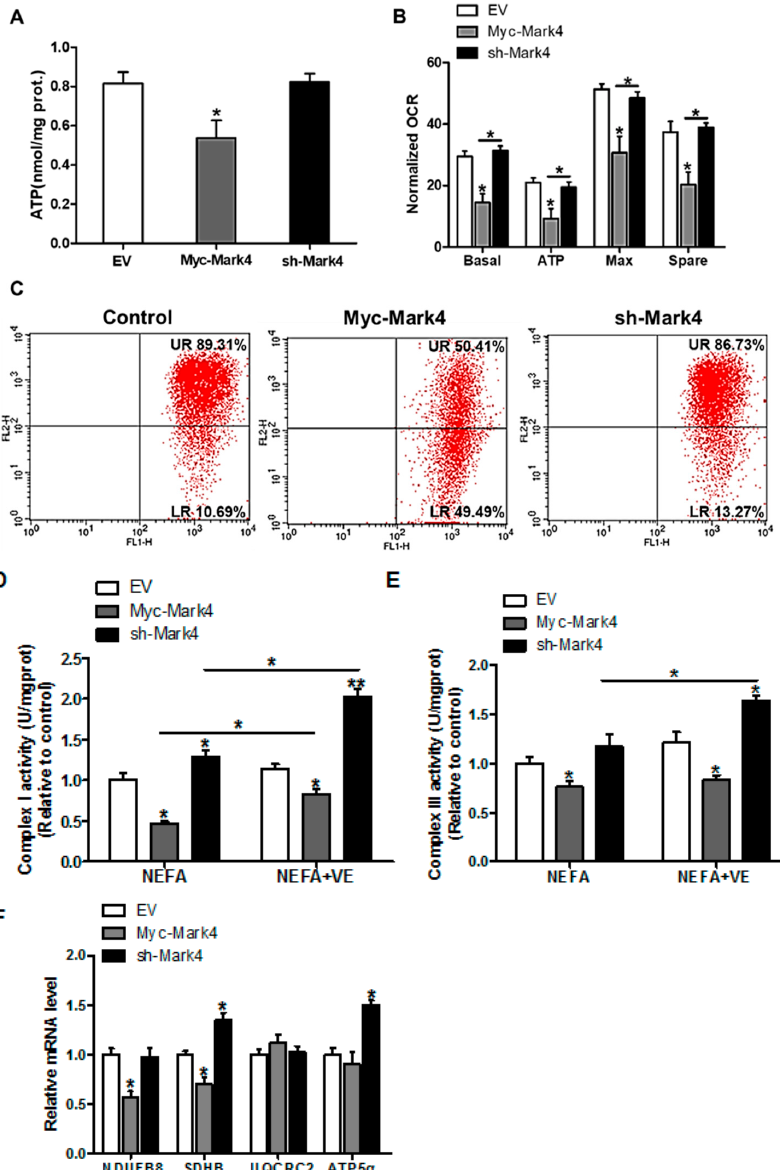
Figure 2. MARK4 blocks mitochondrial oxidative respiration in pig primary trophoblast cells chal- lenged with 400 μ M NEFA. ( A ) Mitochondrial ATP production after transfection with Myc-MARK4, sh-MARK4 for 48 h in cytotrophoblasts. Before assessment of ATP generation, cells were incubated with 400 μ M NEFA for 24 h ( n = 3); ( B ) Mitochondrial respiratory parameters were measured in pig cytotrophoblasts after transfection with Myc-MARK4, sh-MARK4 for 48 h. Cells were then treated with 400 μ M NEFA for 24 h ( n = 3). Oxygen consumption rate (OCR) measurements were normal- ized to total protein level of whole cell lysates extract (pmol O 2 / μ g protein); ( C ) Impaired mitochon- drial function was estimated by JC-1 fluorescent staining using flow cytometry in cytotrophoblasts ( n = 3). The upper right (UR) quadrant depicts the percentage of FL-2 (red channel)-positive cells (high mitochondrial membrane potential) and the lower right (LR) quadrant depicts the percentage of FL-2 (red channel)-negative cells (depolarized mitochondrial membrane potential); ( D , E ) The ac- tivity of mitochondrial complexes I ( D ) and III ( E ) in pig trophoblast cells after transfection with Myc-Mark4, sh-Mark4 for 48 h. Cells were then treated with 400 μ M NEFA or 2 mM VE for 24 h ( n